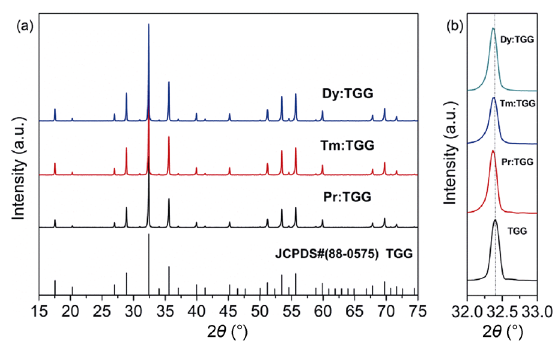
Fig. 1 XRD patterns of (a) 1.0 at% RE:TGG powders calcined at 1150 ℃ for 4 h and (b) the expanded view of the strongest peaks.